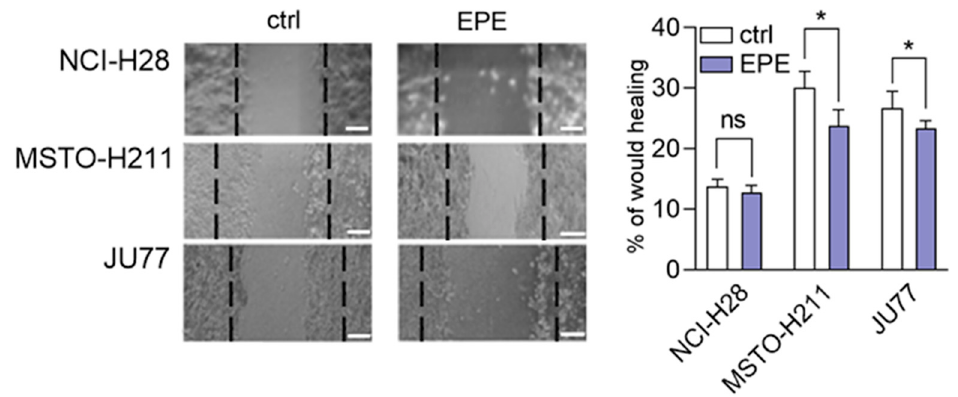
Figure 5. EPE-induced inhibition of wound healing in MSTO-H211 and JU77 cell lines. Analysis of wound healing was made immediately after scratch and 8 h later. The wounded areas were deter- mined on the captured imaged by EVOS FLoid Cell Imaging Station in Image J software. Data are the means of three independent experiments ± SD, ns: non-statistical, * p < 0.05 compared to control.